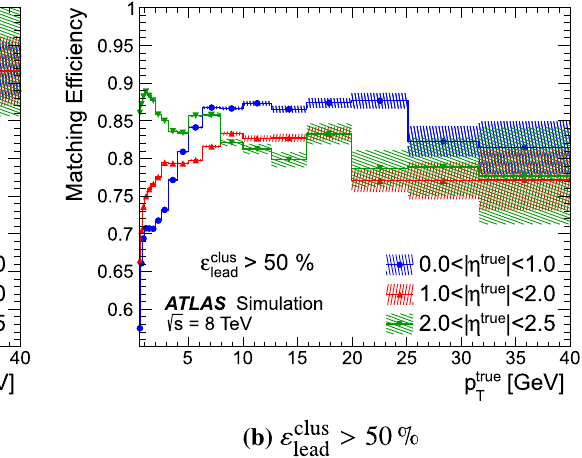
Fig. 17 The probability to match the track to the leading topo-cluster > 90% and ( b ) when ε clus > 50%. The data are taken ( a ) when ε clus lead lead